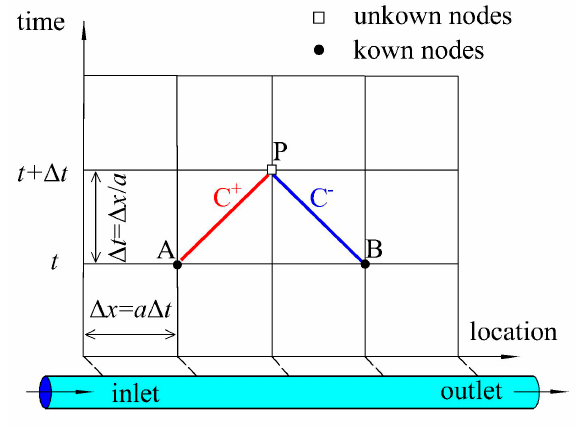
Figure 3. Meshes of pressured flow.